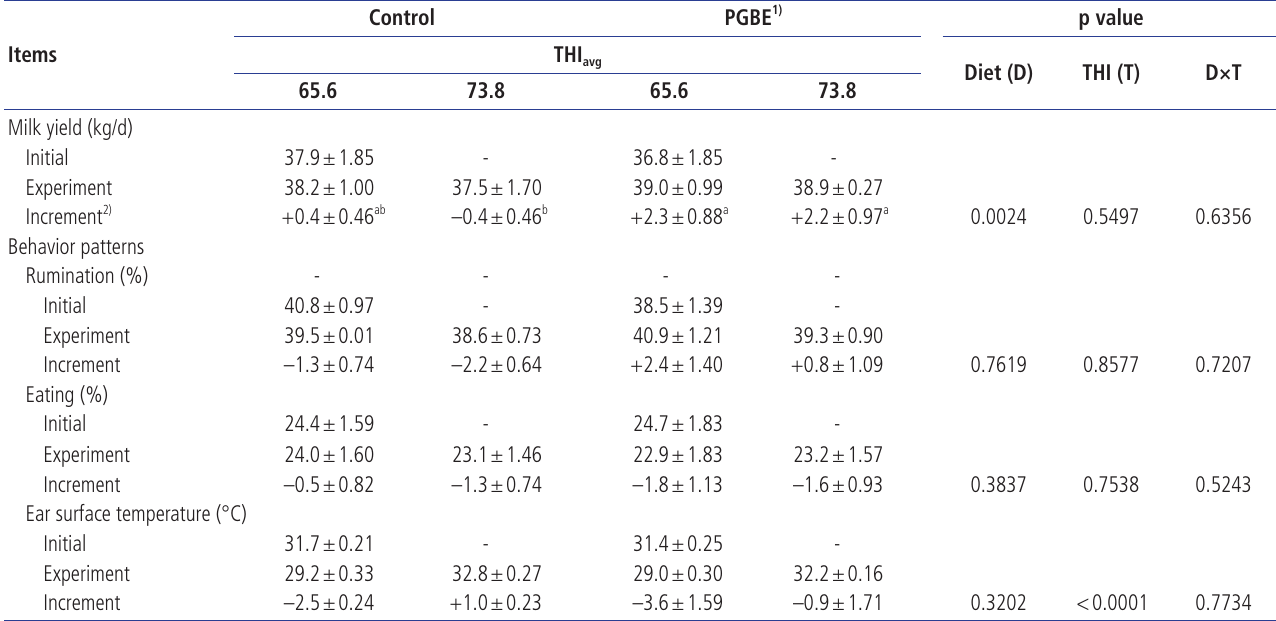
Table 5. Effects of PGBE complex on milk yield, and behavior patterns in dairy cows based on the average temperature-humidity index